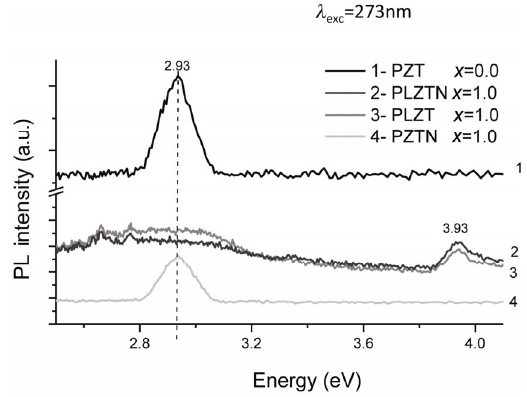
Fig. 6 PL spectra for the same samples in Fig. 4 but exited at 273 nm.